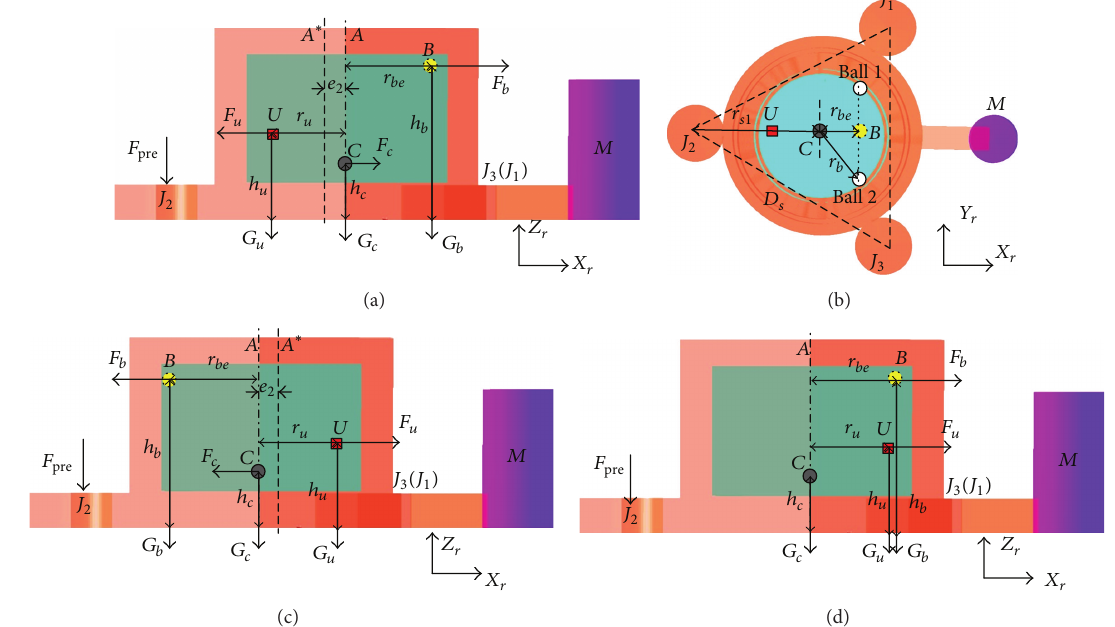
Figure 8: Forces acting on the system at the steady state when a ball balancer is considered.